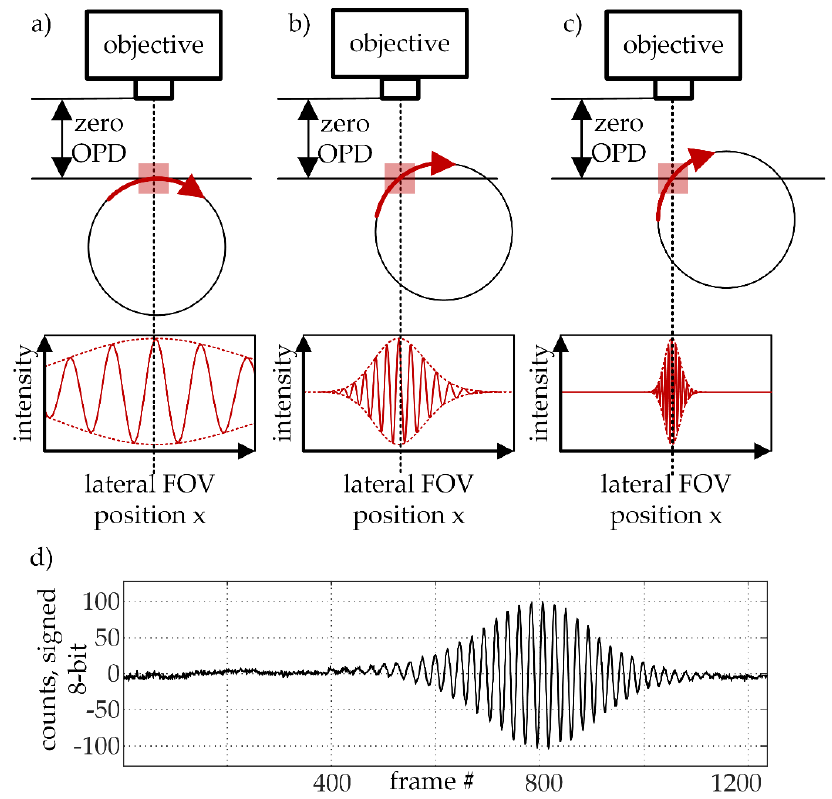
Figure 3. Schematic illustration of the effect of the white light interferometry (WLI) position relative to the scan path on the correlogram. The interference maximum occurs at zero optical path difference (OPD). ( a ) A shallow scan path over the apex yields a wide correlogram. The frequency of the fringes is low and the interference maximum is not as defined as in b). ( b ) A moderately tilted scan path leads to a correlogram with clear interference maximum and clear changes in intensity. ( c ) A steep scan path results in a prominently peaking interference maximum with a comparably high frequency. ( d ) Example of a real correlogram recorded with the experimental rotatory LSWLI